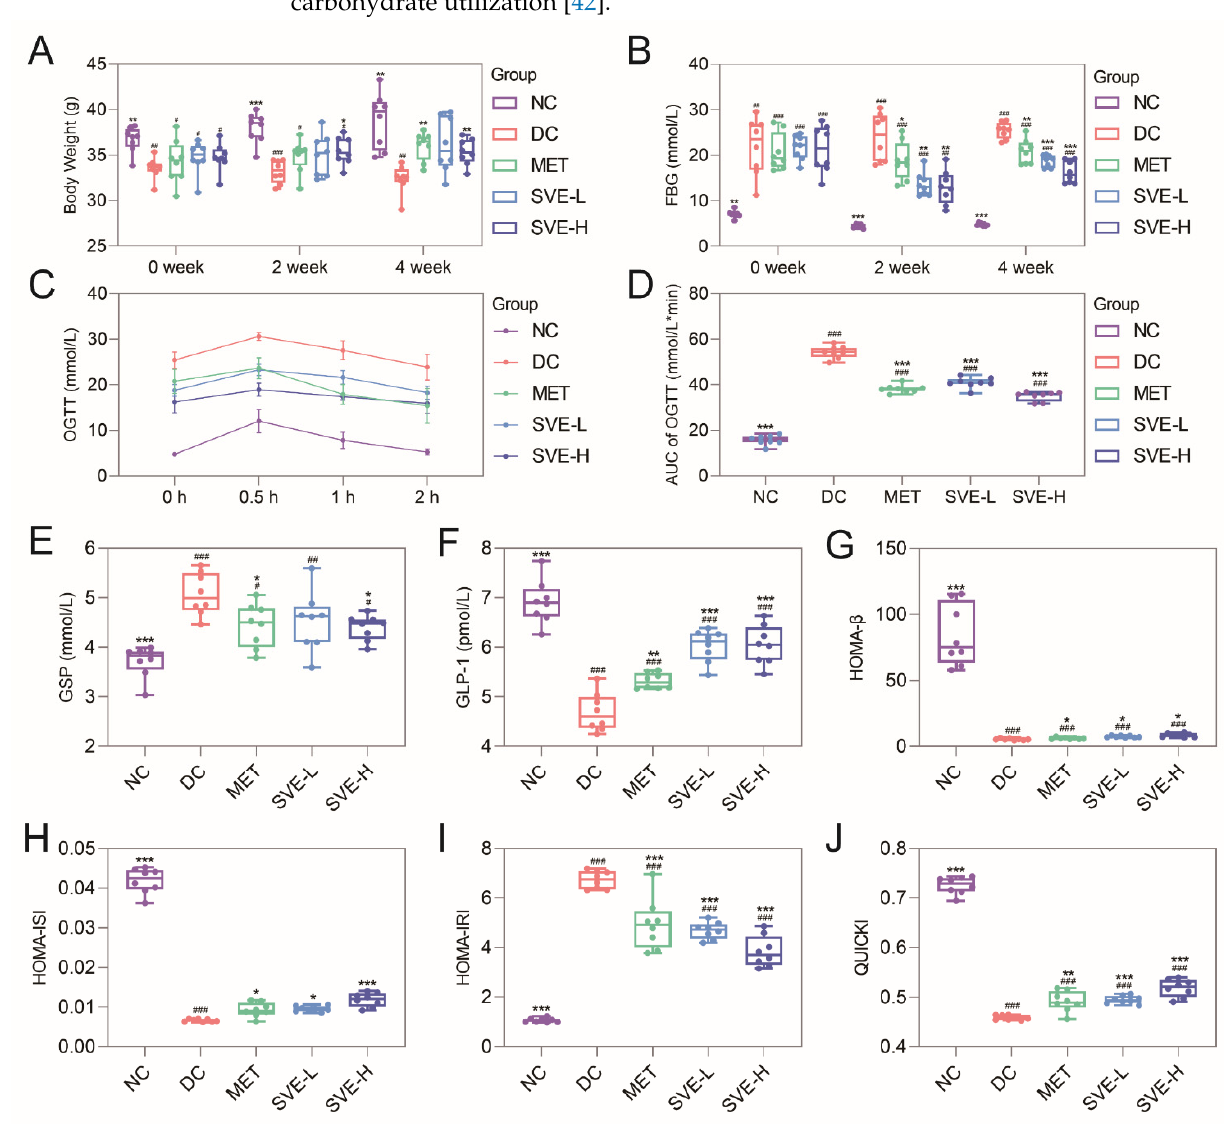
Figure 1. Effects of ethanol extract from Sanghuangporous Vaninii (SVE) intervention on the BW ( A ), FBG ( B ), OGTT ( C ), AUC of OGTT ( D ), GSP ( E ), GLP-1 ( F ), HOMA- β ( G ), HOMA-ISI ( H ), HOMA-IRI ( I ), QUICKI ( J ), in STZ-induced diabetic mice. Note: # p < 0.05, ## p < 0.01, and ### p < 0.001 vs. the NC group; * p < 0.05, ** p < 0.01, and *** p < 0.001 versus the DC group.